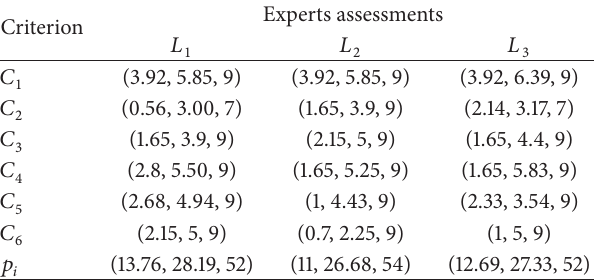
Table 11: The final fuzzy evaluation value for potential